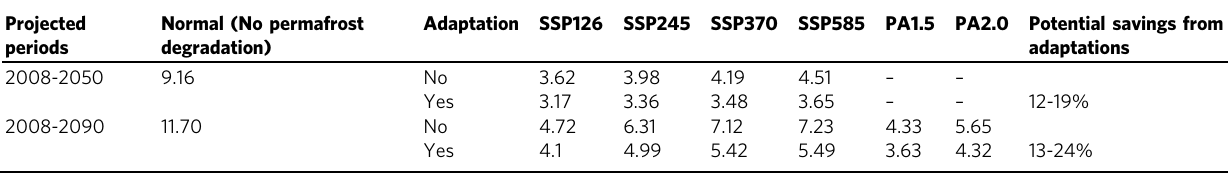
Table 1 Additional costs from permafrost degradation under future scenarios over the Third Pole. The scenarios including four shared socioeconomic pathways (SSPs) and two Paris Agreement (PA) targets. Additional costs is present value in 2008 (billions of US dollars, 2.85% discount rate).